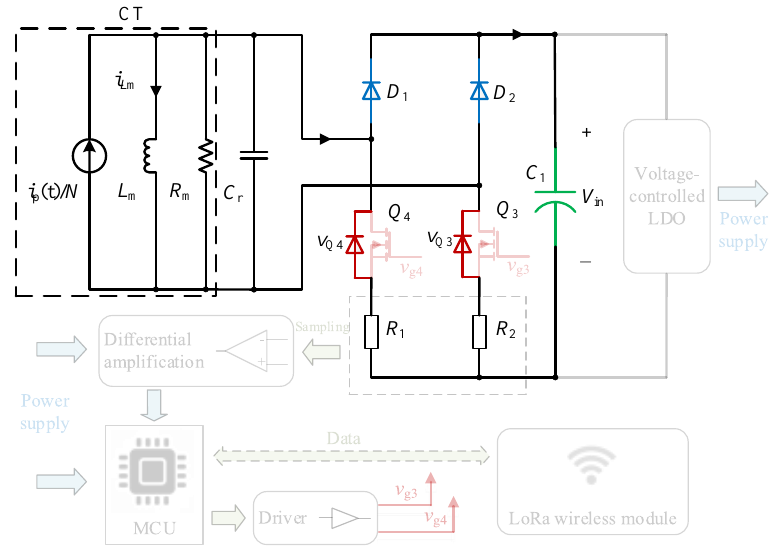
Figure 11. The equivalent circuit of the system operating in energy harvesting mode.